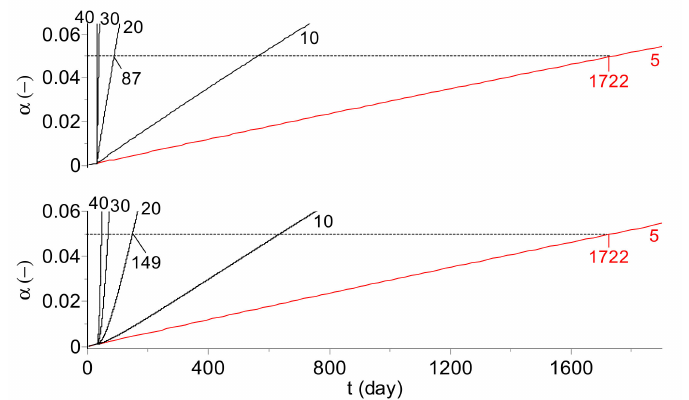
Figure 7. Model vaccine: The change ( α ) of virus infectivity during 30 days at 5 ◦ C followed by the temperature excursions (10, 20, 30, and 40 ◦ C marked in ◦ C on the curves), for the real temperature course (top) and for MKT temperatures calculated by the assumption that E = 83.144 kJ · mol − 1 (bottom). Bold curves show the vaccine deterioration progress at 5 ◦ C, the dependences temperature vs. time for the real temperature and the MKT are identical at a constant temperature. The predicted limit of the shelf life, set arbitrarily as a time when a 5% loss of the infectious titer is reached, amounts at 5 ◦ C to ca. 1722